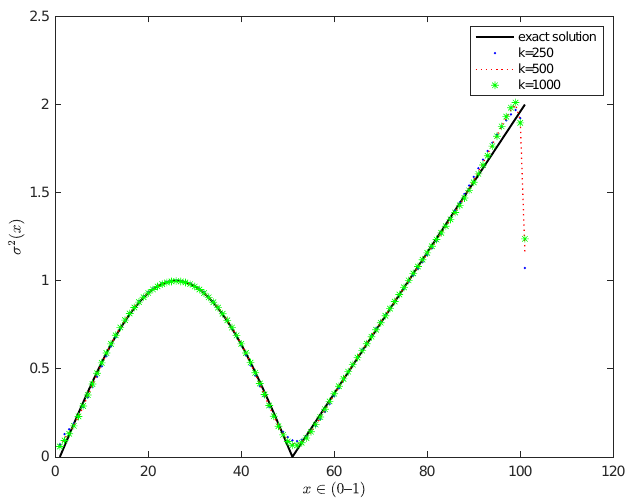
Figure 3. Numerical solution of unknown function σ 2 ( x ) with various iterations for Example 1.